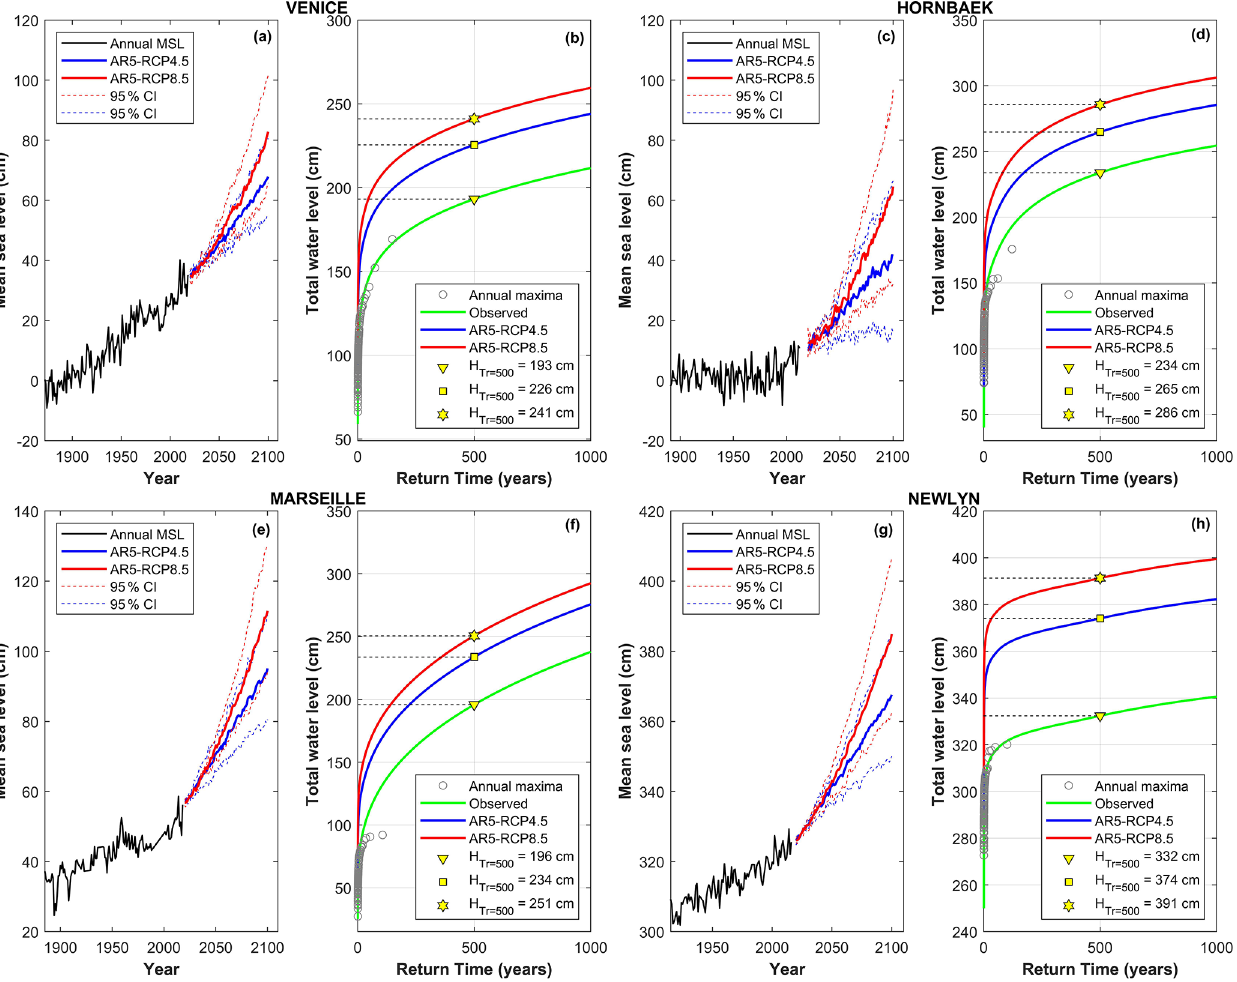
Figure 7. Future total water level projections, with respect to the current mean sea level, in Venice (IT; panels a and b ), Hornbæk (DK; panels c and d ), Marseille (FR; panels e and f ), and Newlyn (UK; panels g and h ). (a, c, e, g) Annual (black line) and future mean sea level until 2100 with RCP4.5 (blue line) and RCP8.5 (red line). Dashed lines represent the 95% confidence intervals. (b, d, f, h) Return period curves for extreme total water level. The green curve represents the estimates obtained with the observed record; the blue and red curves represent the estimates obtained with the projected sea-level rise in the year 2100 with RCP4.5 (blue) and RCP8.5 (red), respectively; the gray dots indicate the observed annual maxima. The triangle, square, and pentagon highlight the heights of extreme total water levels for a fixed return period equal to 500